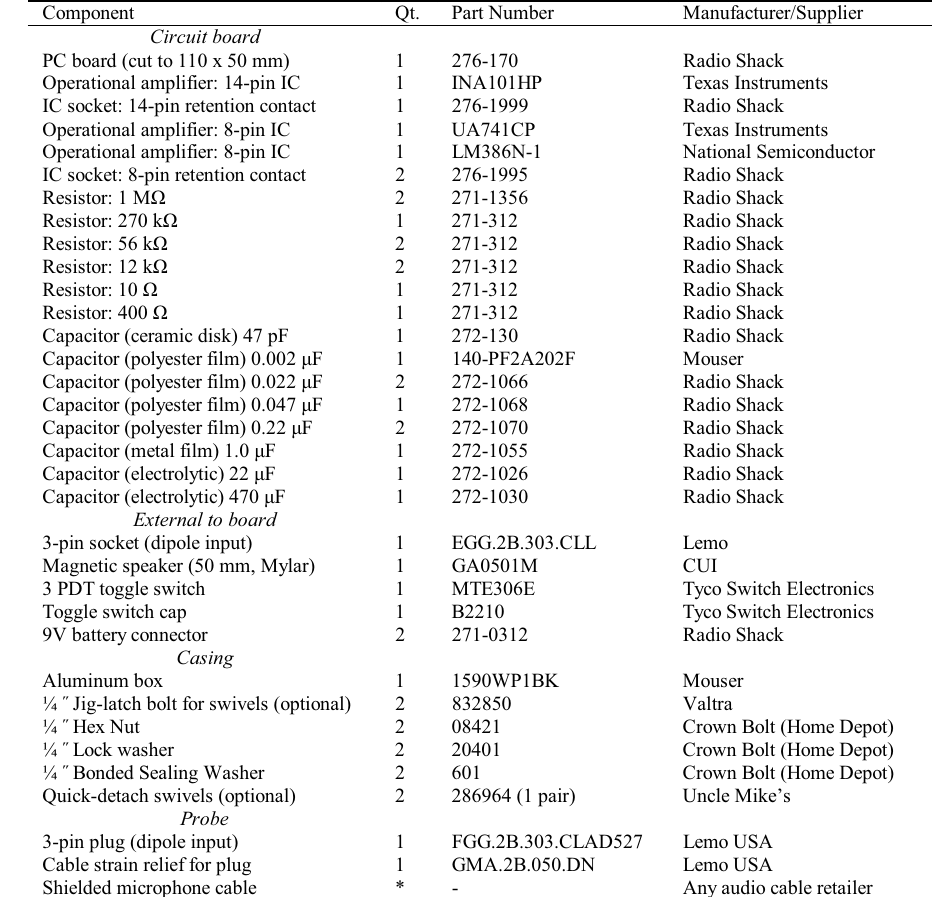
Table 1. List of components for the construction of an Electric Fish Finder and dipole probe. Qt. = quantity. IC = integrated circuit. F = Farad. Ù = Ohm. * See text for discussion of useful cable